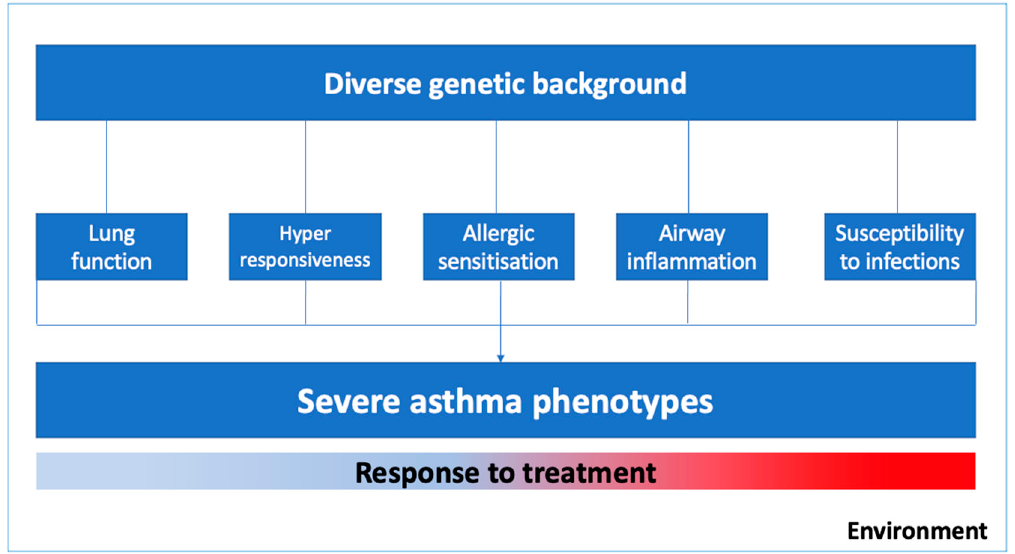
Figure 1. Environmental factors and biogenetic mechanisms related to severe asthma phenotypes.